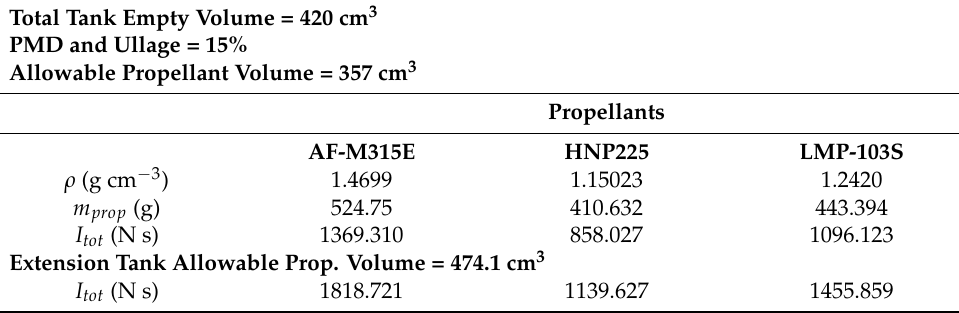
Table 9. MIMPS-G total impulse I tot with the selected green